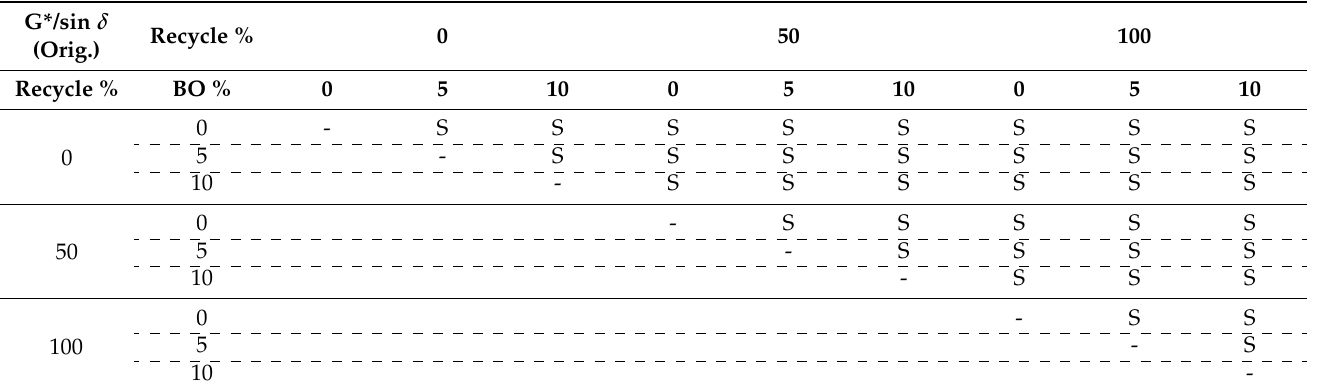
Table 4. Statistical analysis results of the G*/sin δ for original condition as a function of aged binder contents and the addition of base oil ( α = 0.05).